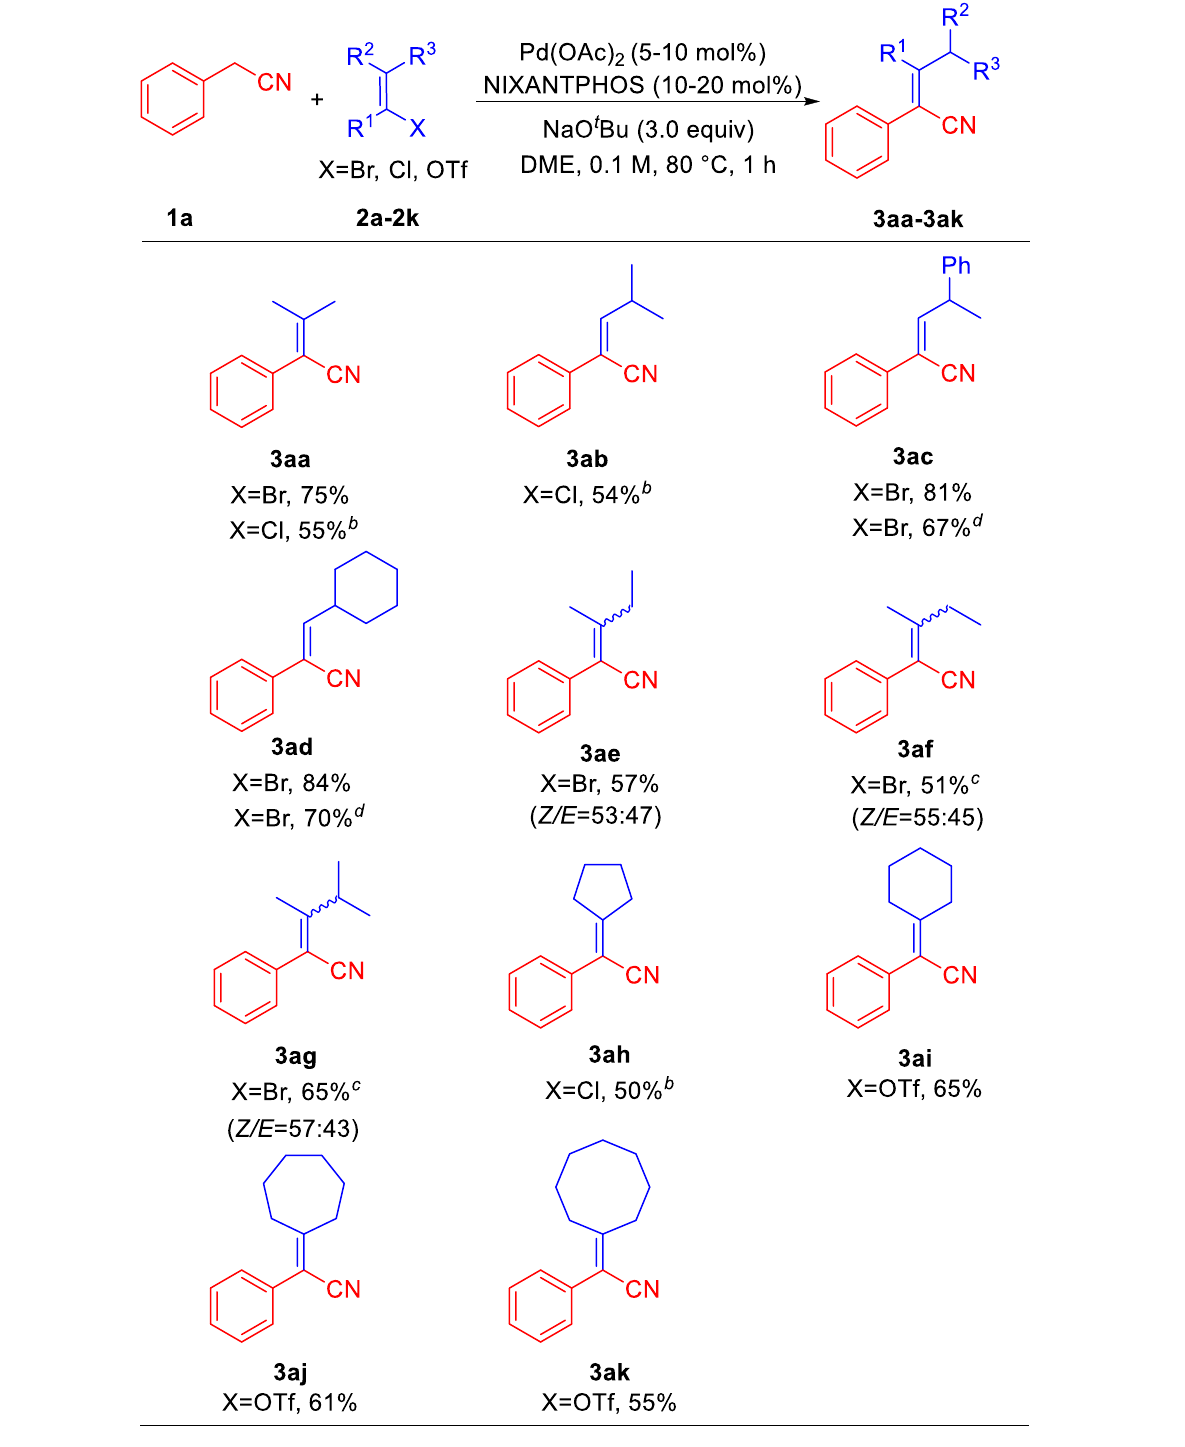
TABLE 2 Scope of vinyl halides/tri fl ates a